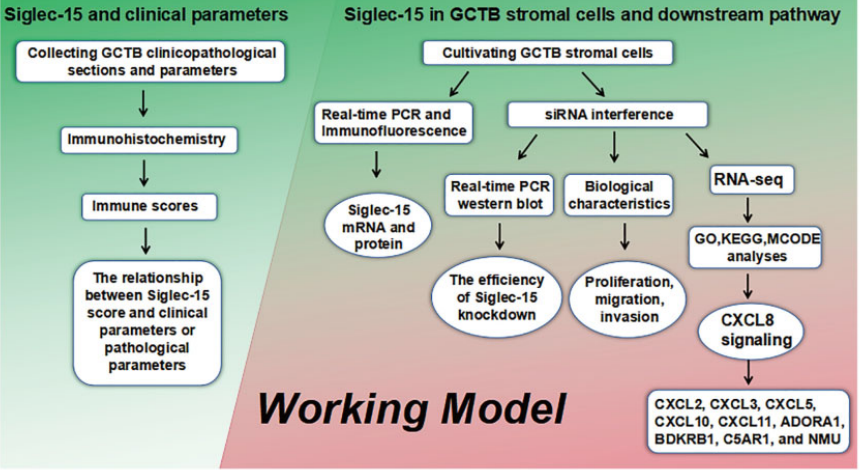
Figure 1. Working model illustrates the association between Siglec-15 and clinical parameters, the influence of high Siglec-15 for GCTB stromal cells, as well as the prediction of downstream pathways of Siglec-15 in GCTB stromal cells.